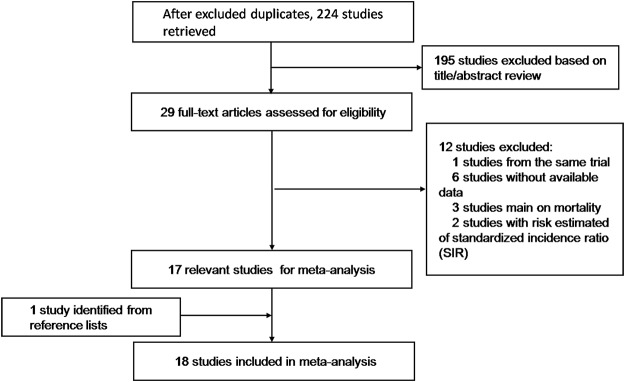
The detailed steps of literature search in the present meta-analysis.